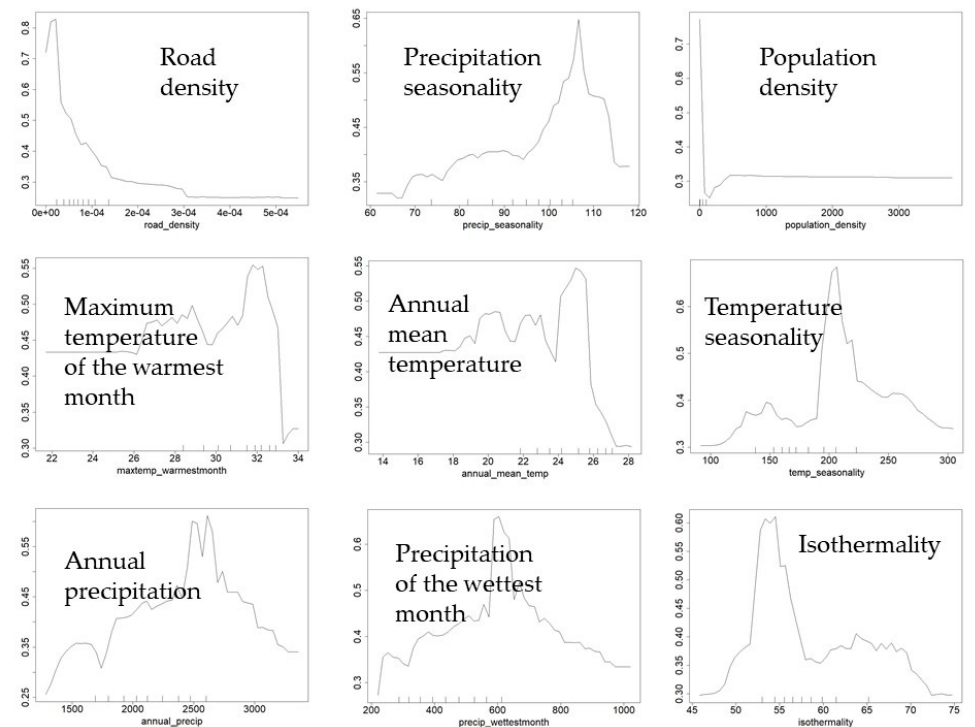
Figure A5. Top nine predictor variables for the 3S region (Sekong-Srepok-Sesan river basins) model make up 47% of the variable contribution. Note the small vertical lines on the x axis (rug) that indicate where the majority of the data points are located.